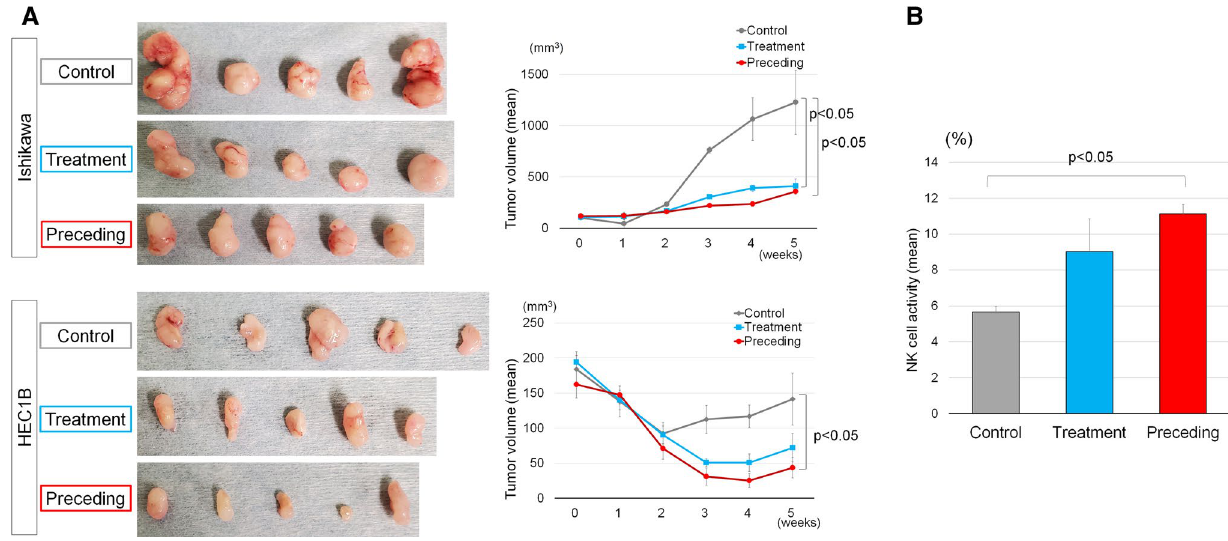
Fig. 4 Effect of daily 6-MITC oral administration on Ishikawa and HEC1B xenograft tumor growth and NK cell activity in nude mice. Xeno- grafted mice were divided into three groups (Control, Treatment, and Preceding groups); each group had five mice. Oral administration of 6-MITC was started from xenografting in the "Treatment" group and 4 weeks before xenografting in the "Preceding" group. A Pictures are at the same scale and show each tumor removed from each mouse after euthanization at 5 weeks. 6-MITC oral administration significantly reduced the tumor volume in both "Treatment" and "Preceding" groups compared with the Control group. B 6-MITC oral-administration enhanced NK-cell activity in xenografted nude mice, with significance in the "Preceding" group. Graphs indicate mean values, and error bars indicate standard